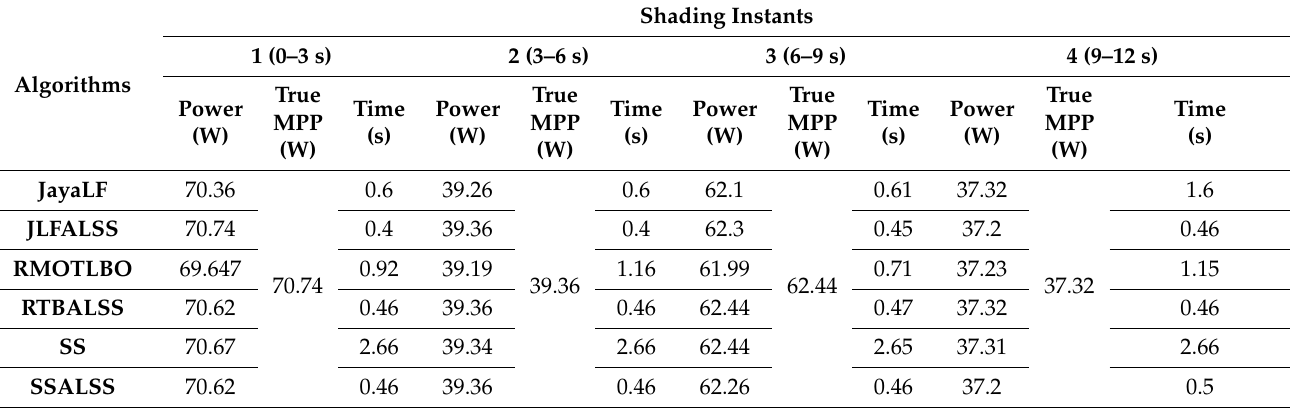
Table 4. Performance summary for the “randomly-varying insolation” dynamic scenario.